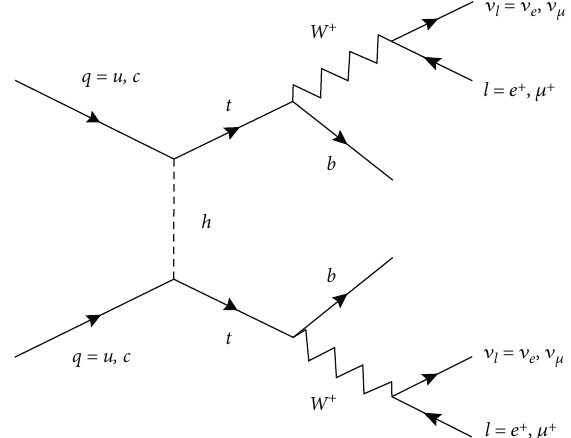
Figure 3: Feynman diagram of leptonic decay of top-Higgs FCNC process: for sake of simplicity, we give a compact form of the process which includes two new physics vertex. Dominant contribution will come from pp ⟶ tt process due to the large values of PDF of up-type quarks in